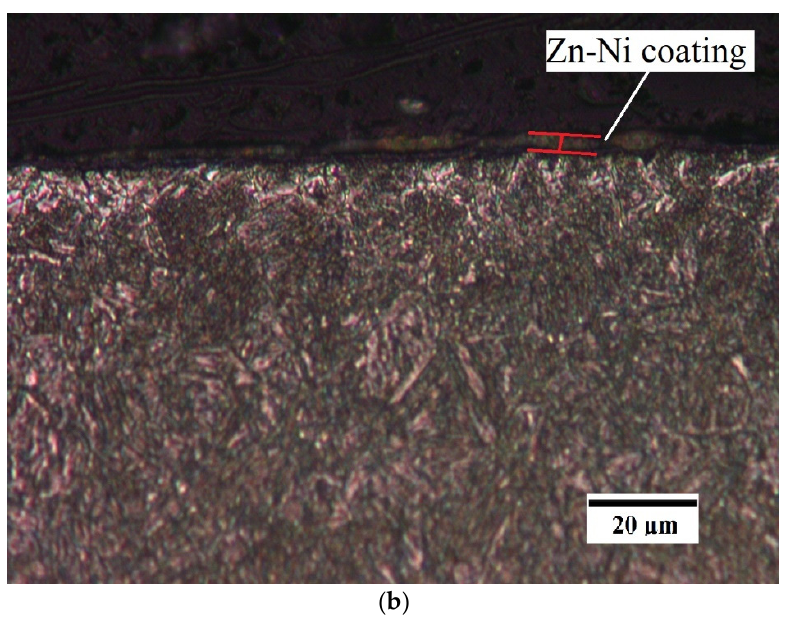
Figure 6. Optical microscopy images of ( a ) Cd and ( b ) Zn-Ni electroplated coatings (500×).